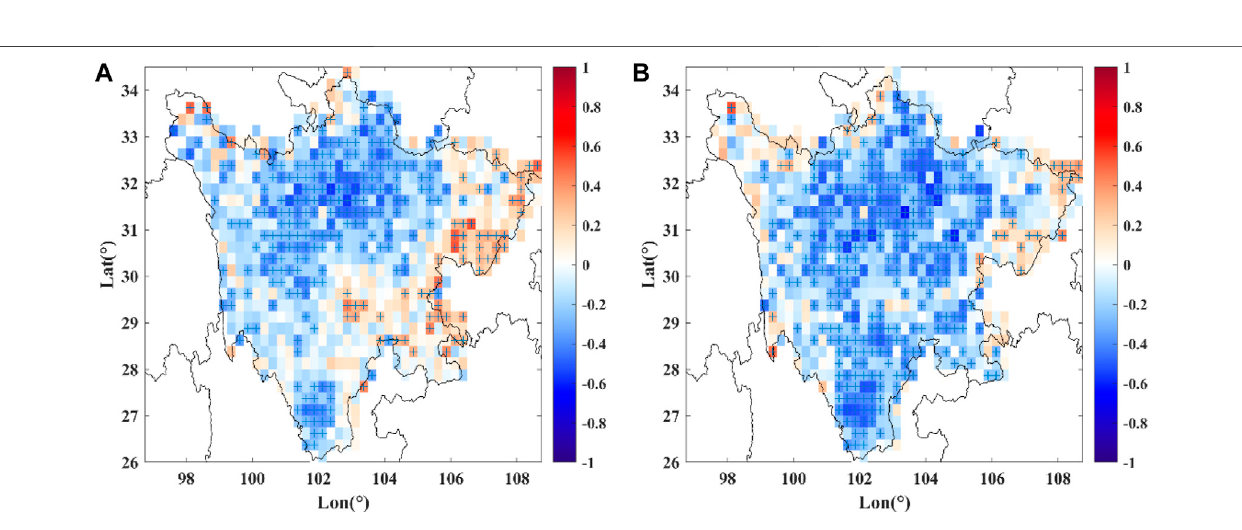
FIGURE 4 | Pearson correlation coef fi cients between (A) the sulfate aerosol and positive CG lightning relative frequency, and correlation coef fi cients between (B) theBCaerosolandpositiveCGlightningrelativefrequencyinSichuanduringthewarmseason.Thecrosssymbolindicatesthatthegridhaspassedthe95%signi fi cance